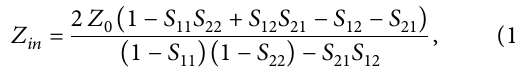
Figure 11: Tag’s (a) resistance and (b) reactance variation with varying metal sheet